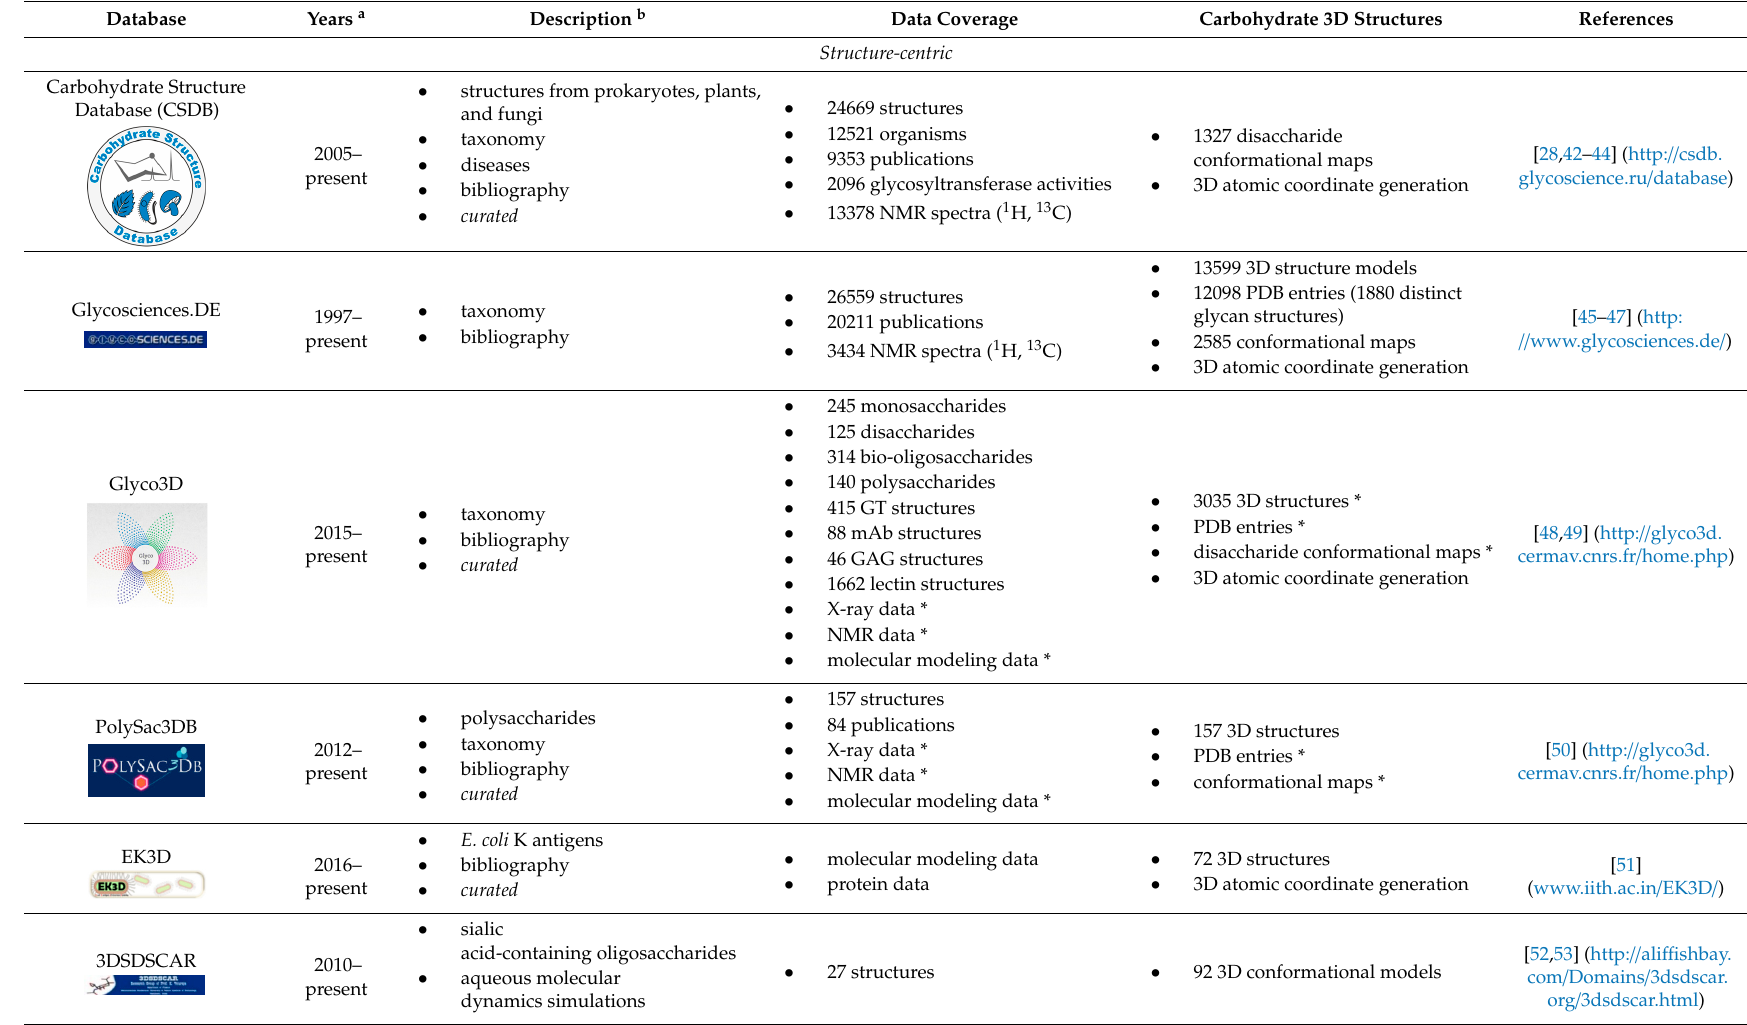
Table 1. Carbohydrate databases with 3D structure support.